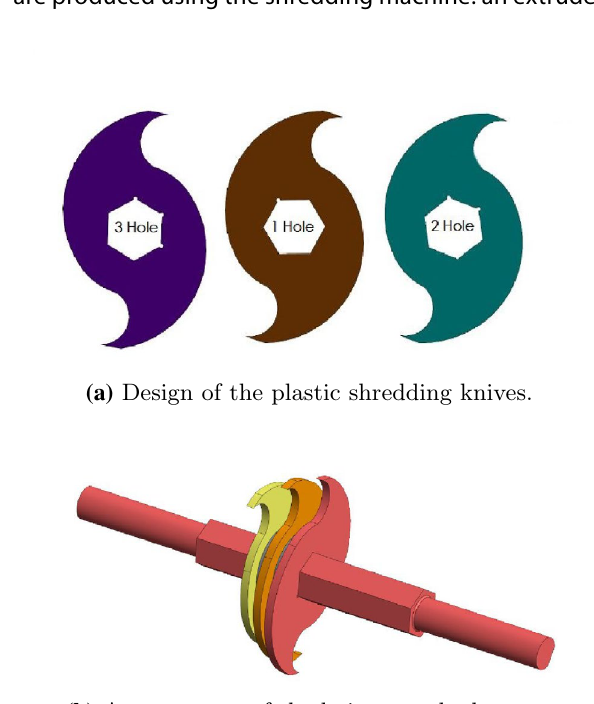
(b) Arrangement of the knives on the hexago- nal